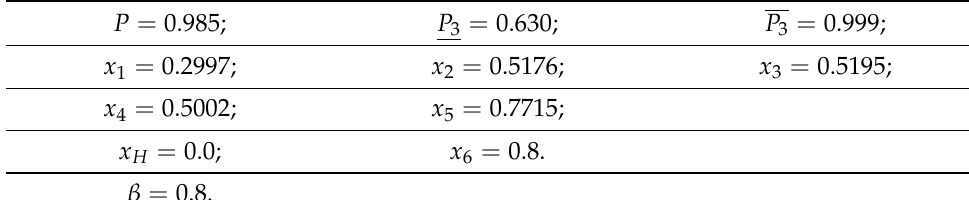
Table 10. Values of M [ DN M ] and D [ DN M ] depending on the sample size.